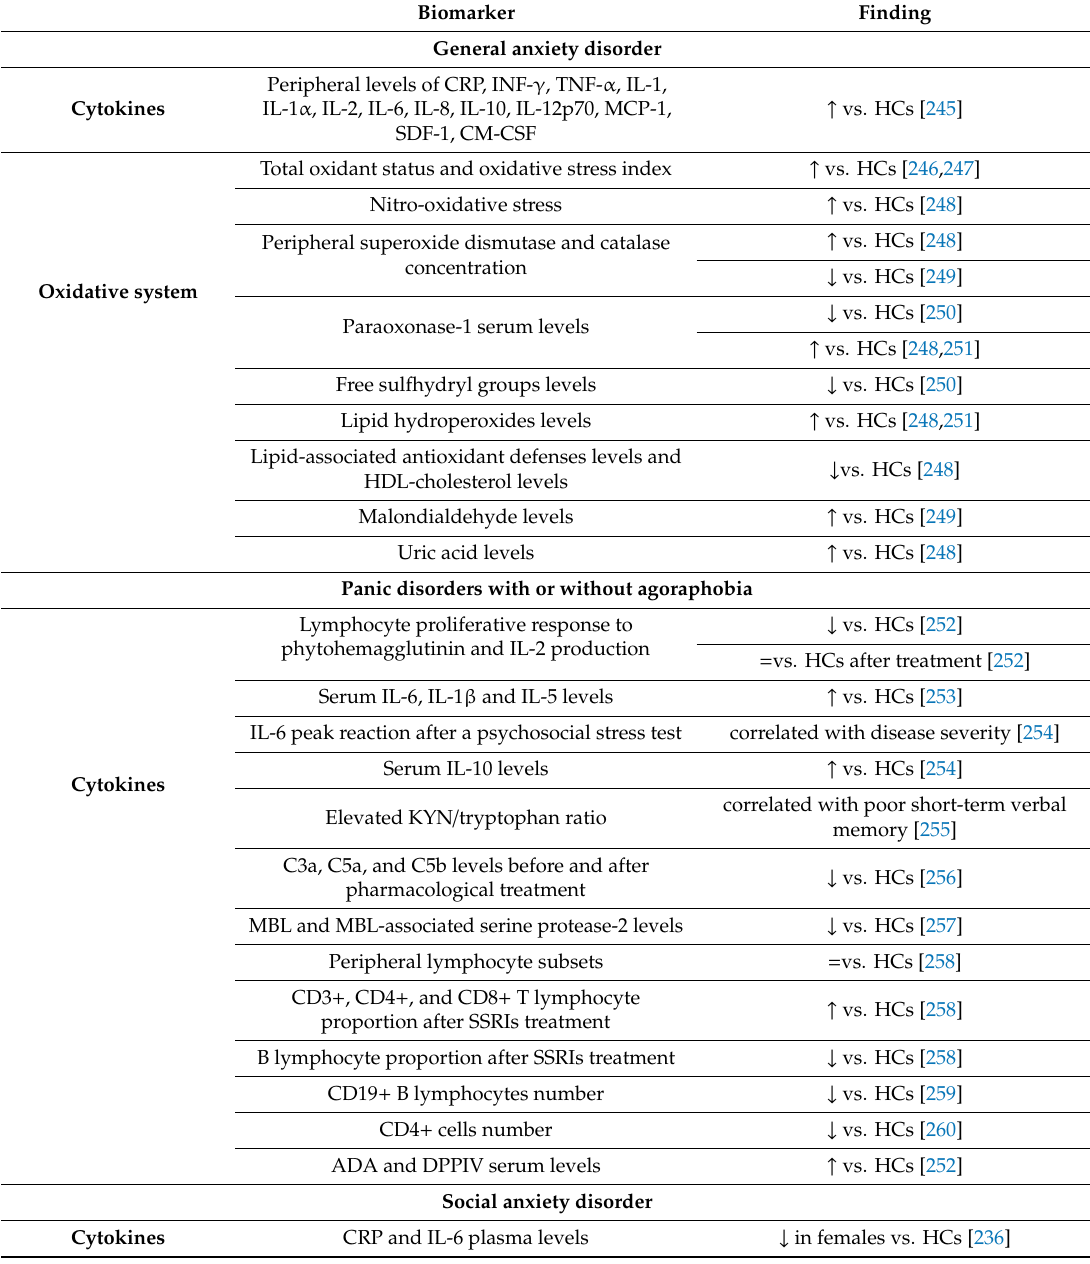
Table 5. Summary of the findings related to the inflammation and immune system involved in GAD, PDA, and